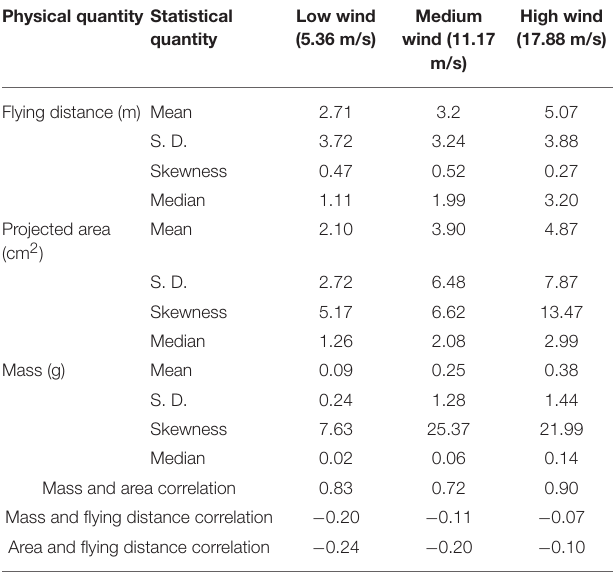
TABLE 1 | Summary of the measured parameters at different mean wind speeds. Physical quantity Statistical quantity